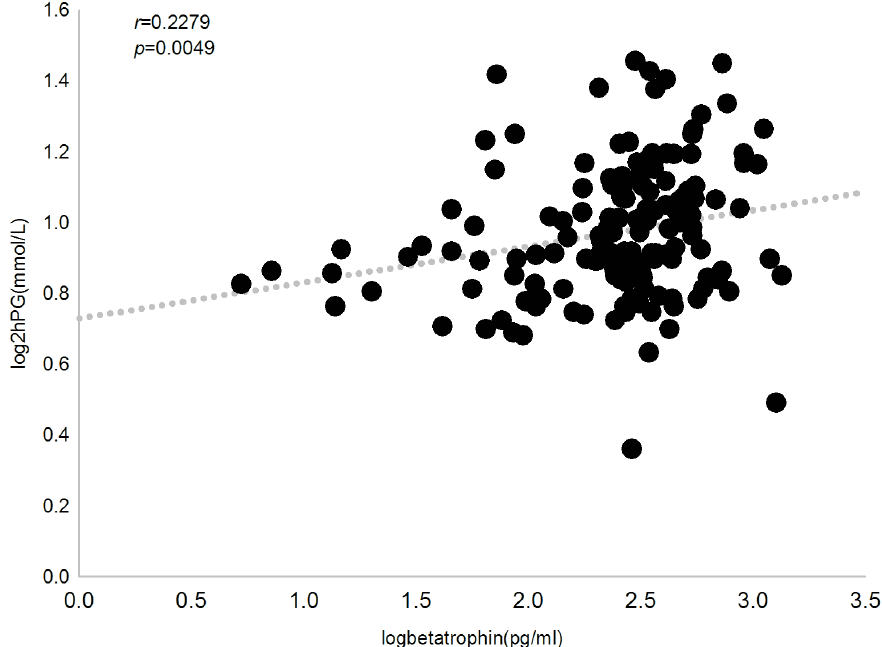
Fig 4. Correlation between plasma betatrophin concentration and 2-hour plasma glucose level. Betatrophin level positively correlates with 2-hour plasma glucose level in all subjects ( r = 0.228, P = 0.0049).